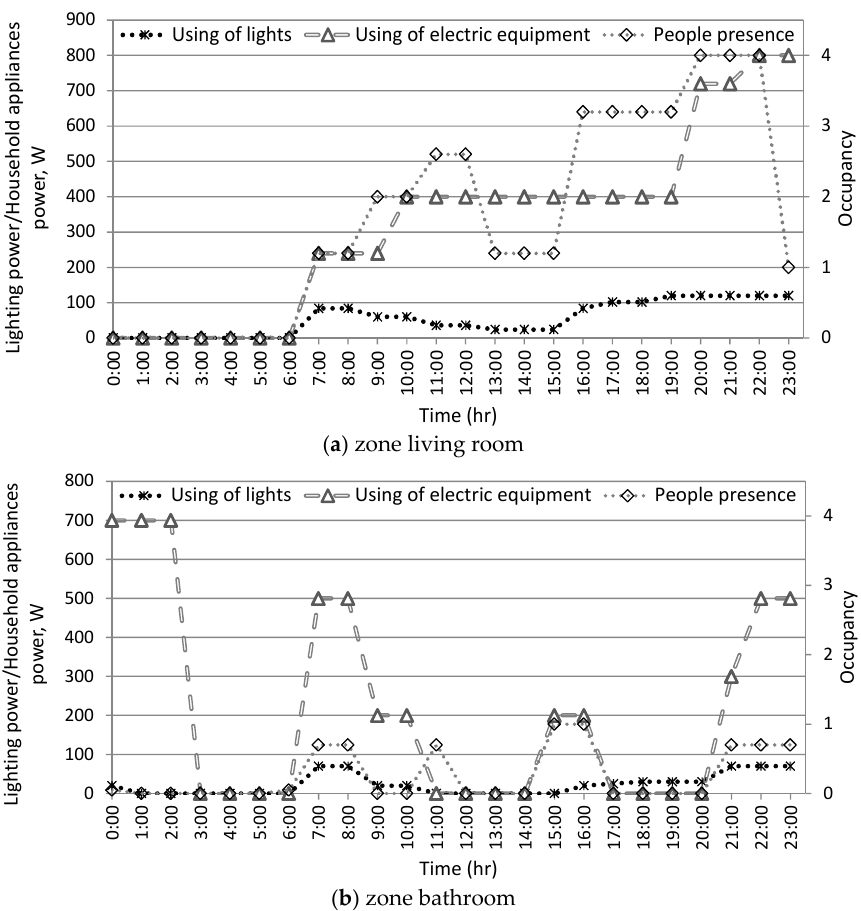
Figure 3. Schedules of the people presence, the use of lighting devices and the use of electric equipment ( a ) in a living room and ( b ) in a bathroom.